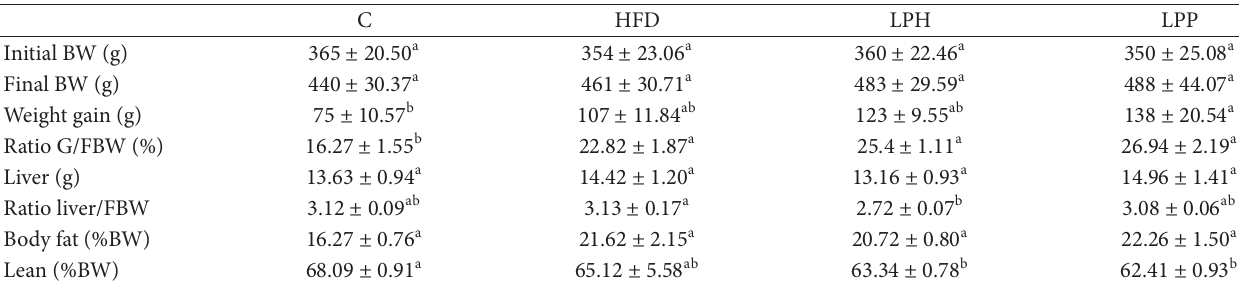
Table 1: Effect of lactobacilli strains on body weight, weight gain, and organ weight in rats.